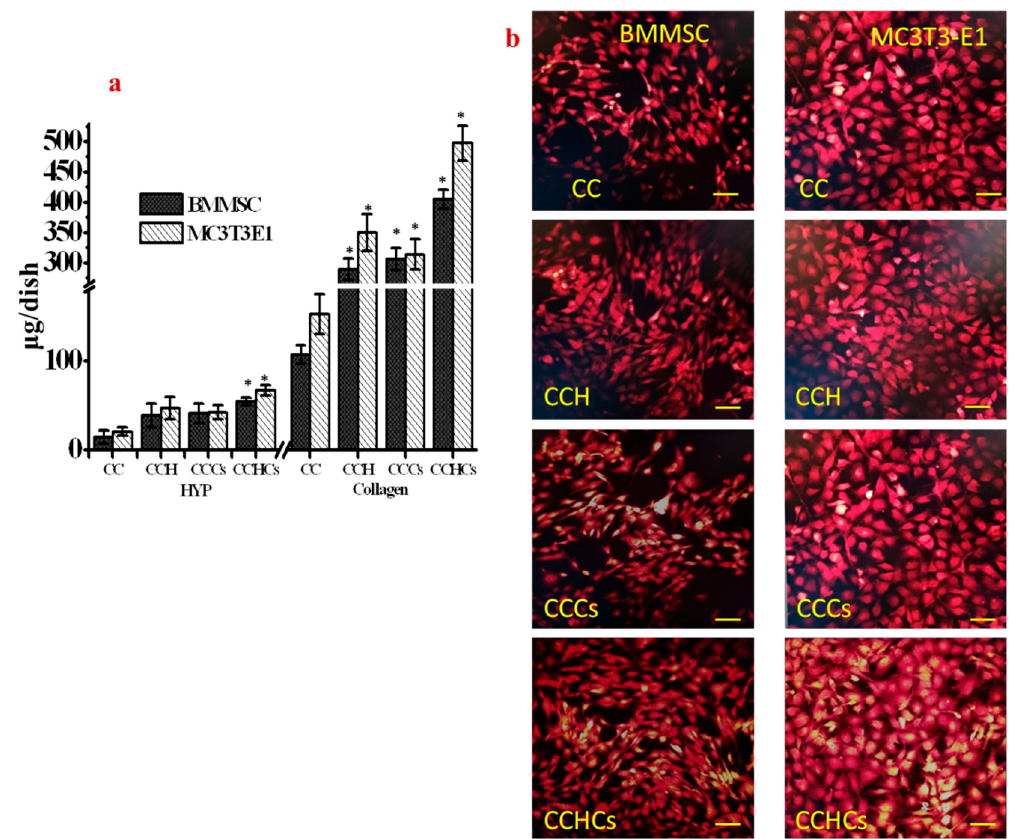
Figure 5. ( a ) The effect of chitosan-collagen-based bio-mimic 3D matrices on hydroxyproline and collagen synthesis in bone cells; * p < 0.05 vs. CC. ( b ) Immunocytochemistry evaluation of collagen I expression of bone cells cultured for 14 days. Scale bars: 100 µm. CC: chitosan-collagen 3D matrix, CCH: chitosan-collagen-hydroxyapatite 3D matrix, CCCs: chitosan-collagen-chondroitin sulfate 3D matrix, and CCHCs: chitosan-collagen-hydroxyapatite-chondroitin sulfate 3D matrix.